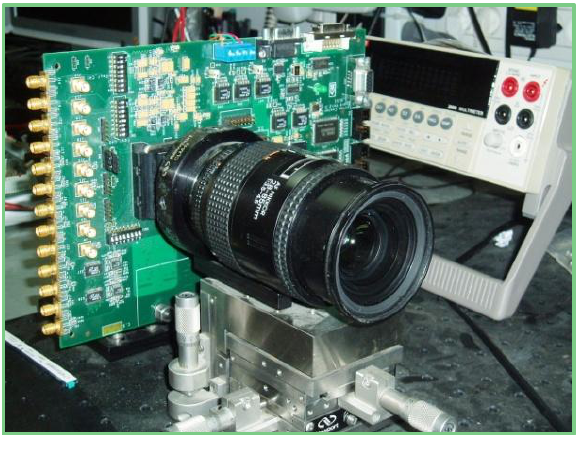
Figure 5. Sensor Test Board.